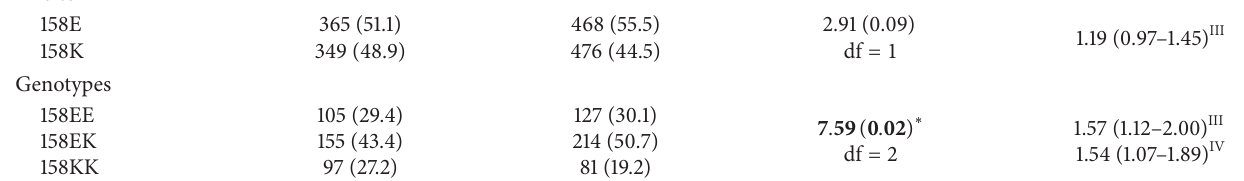
Table 3: The FMO3 genotype cigarette smoking interaction and susceptibility to essential hypertension in Kursk population. EH patients 𝑁 (%) FMO3 genotype